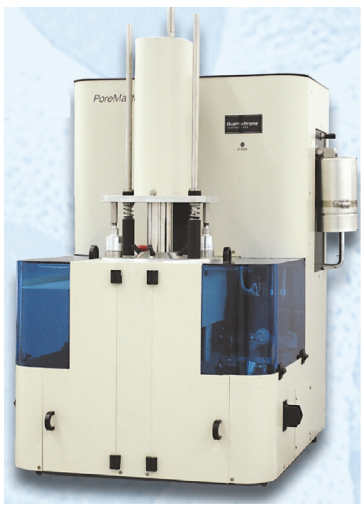
Figure 6: PoreMaster